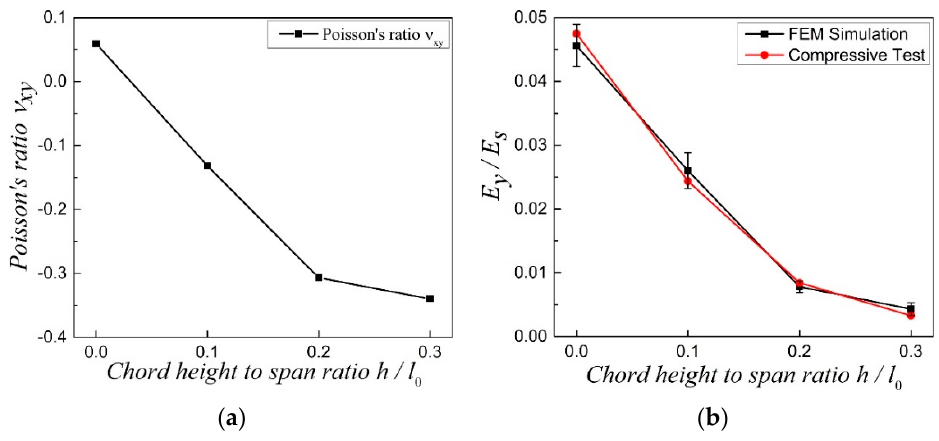
Figure 3. ( a ) Poisson’s ratio ν xy ( ν xy = ν y x = ν xz = ν zx = ν yz = ν zy ) and ( b ) relative Young’s modulus E y / E s ( E x = E y = E z ) of the COF0, CCF1, CCF2 and CCF3, in which E y is the Young’s modulus of the CCF in the y direction and E s is the Young’s modulus of the solid of which the CCF are made of. Except the examples of COF0, CCF1, CCF2, and CCF3, to further investigate the effect of